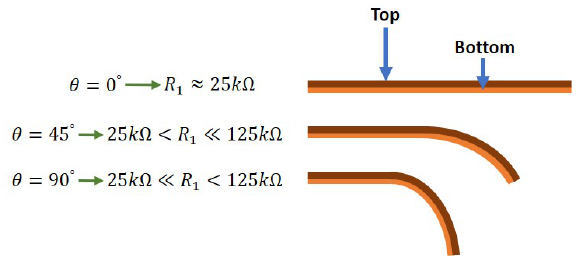
Figure 2. Illustration on the relation between the flex sensor bending angle, θ , and the resistance, R 1